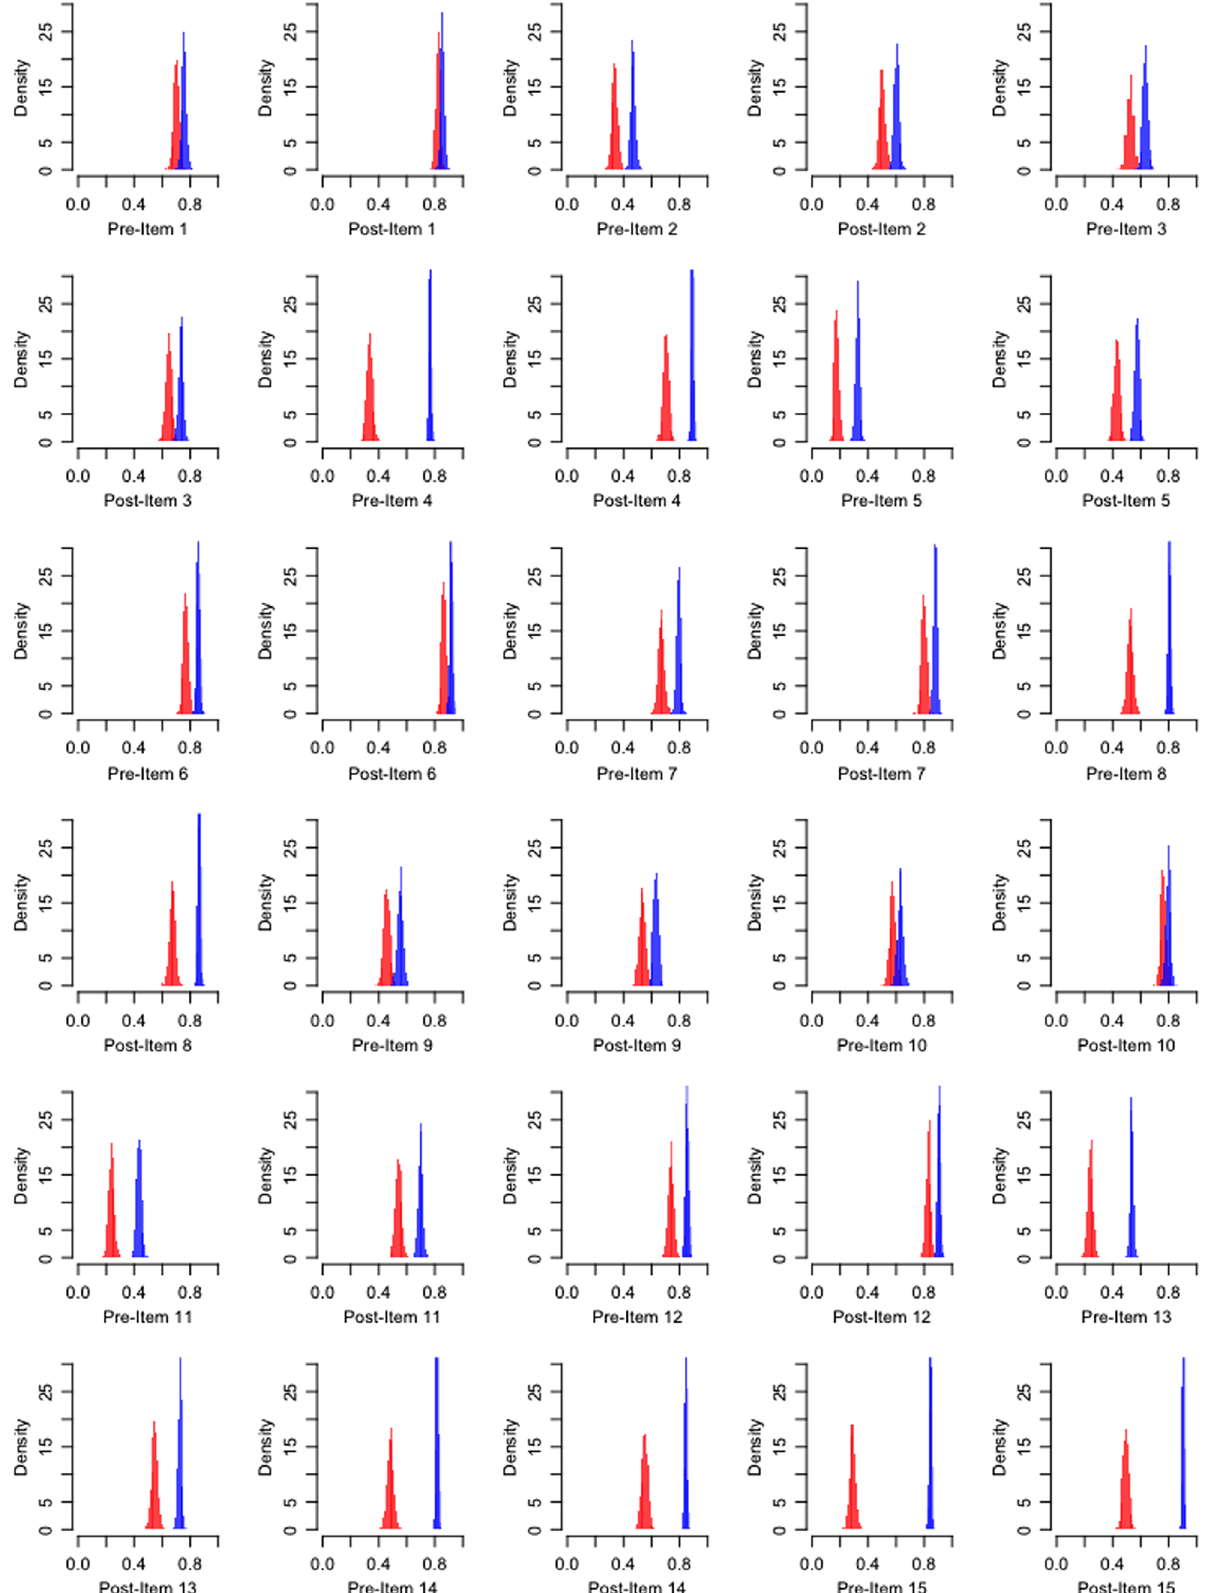
FIG. 7. Average item scores for questions 1 – 15 pre and post-test. Averages from dichotomous scoring are in red and the partial credit scoring item averages are in